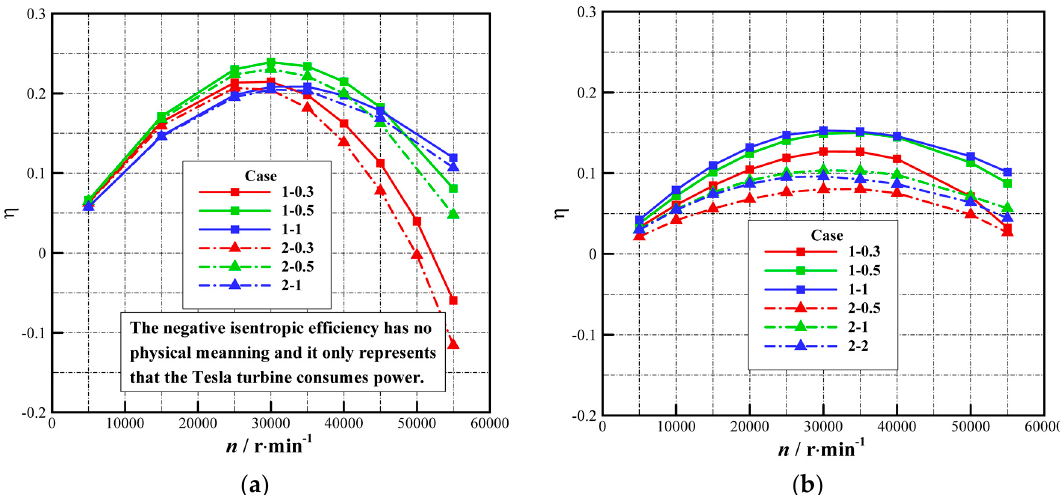
Figure 4. Isentropic efficiency versus rotational speed of each turbine case for two kinds of multichannel Tesla turbines: ( a ) one-to-one Tesla turbine; and ( b ) one-to-many Tesla turbine. Tesla turbines: ( a ) one-to-one Tesla turbine; and ( b ) one-to-many Tesla